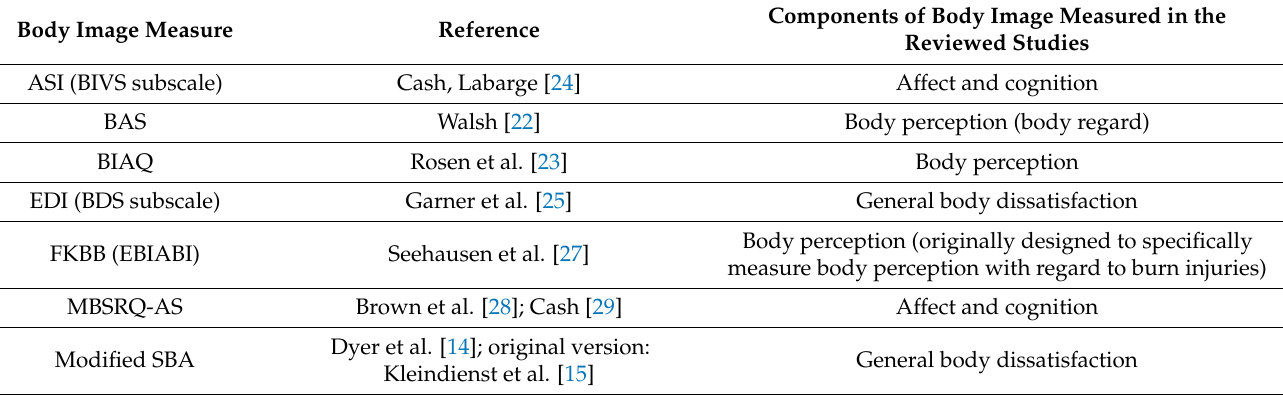
Table 2. Characteristics of the measures used in the reviewed studies (for a review on body image measures, see [26]). Components of Body Image Measured in the Body Image Measure Reference Reviewed Studies ASI (BIVS subscale) Cash, Labarge [24] Affect and cognition BAS Walsh [22] Body perception (body